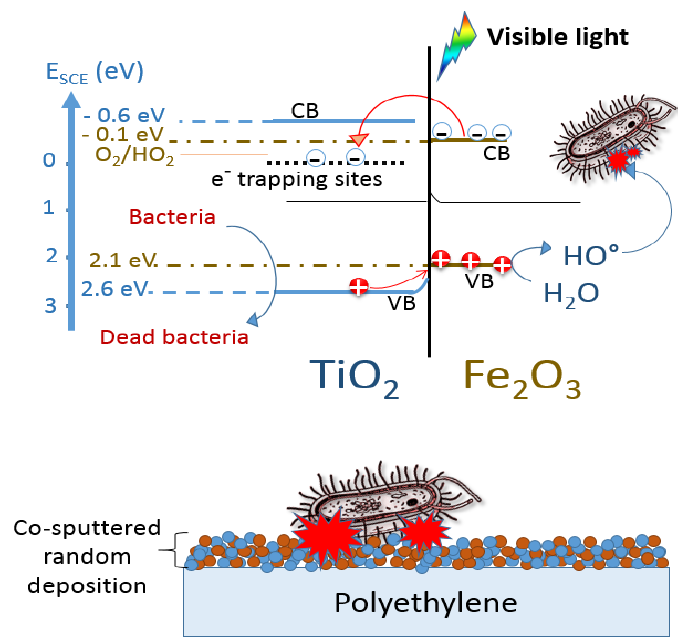
Figure 7. Mechanism suggested for bacterial inactivation by co-sputtered by FeOx-TiO 2 -PE films under visible light, showing the IFCT process taking place between Fe 2 O 3 induced by visible light.